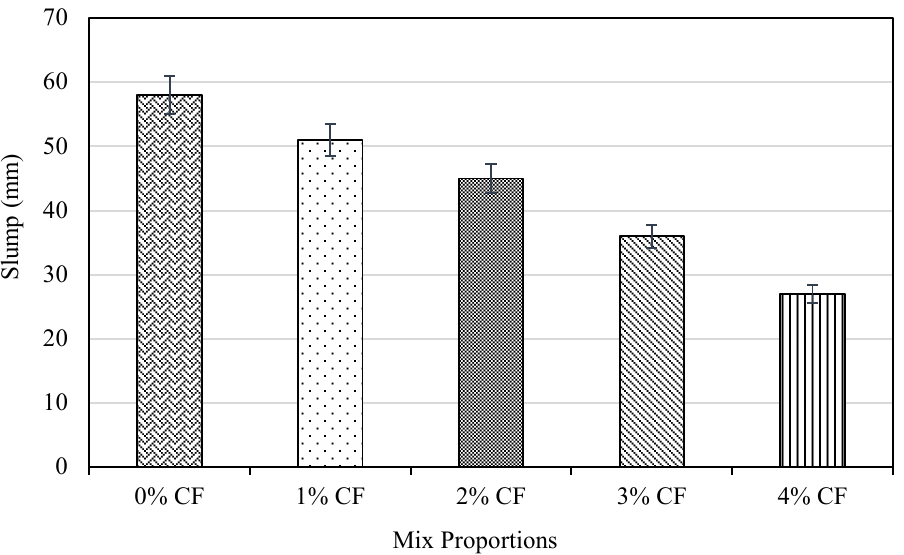
Figure 3. The slump of coir fiber-reinforced cement-based hybrid concrete recorded in the experi- ment.